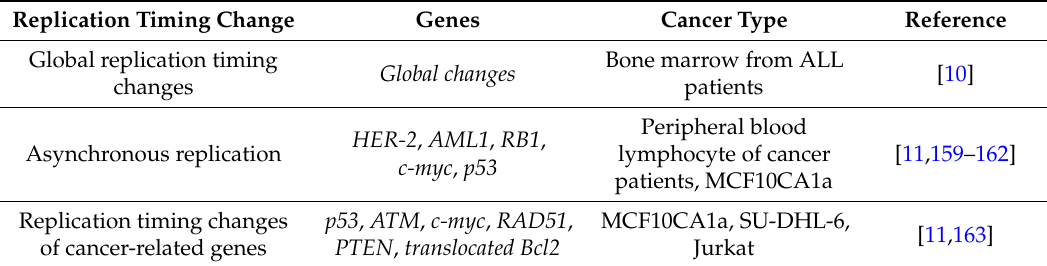
Table 3. Studies linking replication timing changes to